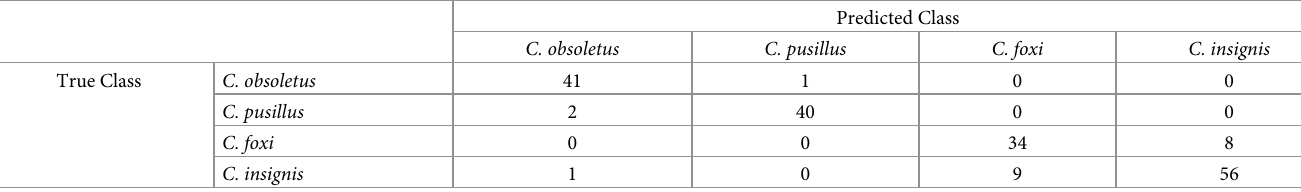
Table 4. Confusion matrix obtained by the LDA classifier for the four Culicoides species classification